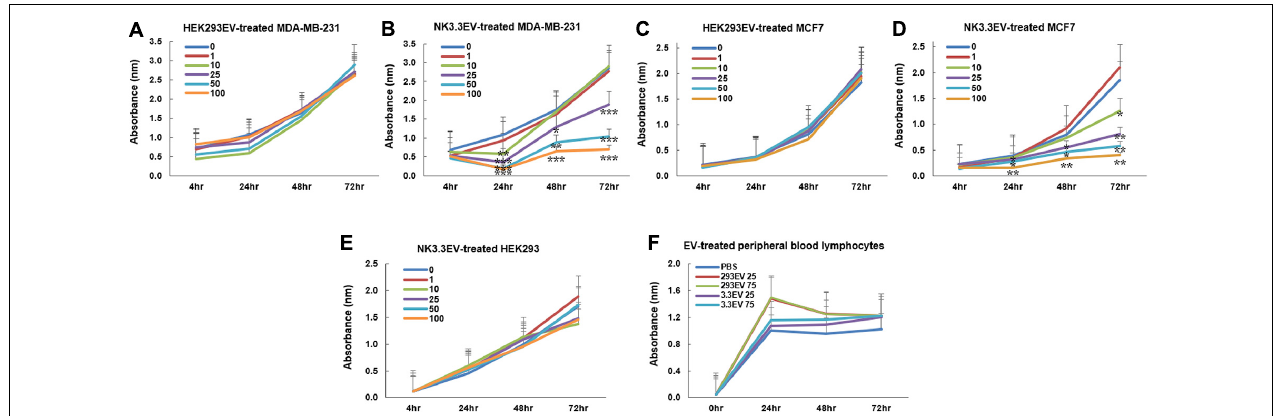
FIGURE 5 | Inhibition of breast cancer cells but not non-tumorigenic cells by NK3.3-derived EV treatment in vitro. (A–D) Dose response analyses were performed using concentrations of EVs ranging from 1 to 100 µ g/ml or PBS (0). Cells were monitored daily using a crystal violet viability assay. MDA-MB-231 cells were treated with either (A) HEK293 EVs or (B) NK3.3 EVs, and MCF7 cells treated with either (C) HEK293 EVs or (D) NK3.3 EVs. Mean absorbance ± SE; n = 3. (E) HEK293 embryonic kidney cells were treated with the same increasing NK3.3 EV concentrations and stained with crystal violet. (F) IL-2 stimulated peripheral blood lymphocytes from a healthy donor were treated with 25 or 75 µ g/ml of either HEK293 EVs or NK3.3 EVs; metabolic activity was monitored using WST-1. Mean absorbance ± SE; n = 3. p- Values determined by comparison of NK3.3 EV-treated cells at each treatment concentration to HEK293 EV-treated cells at